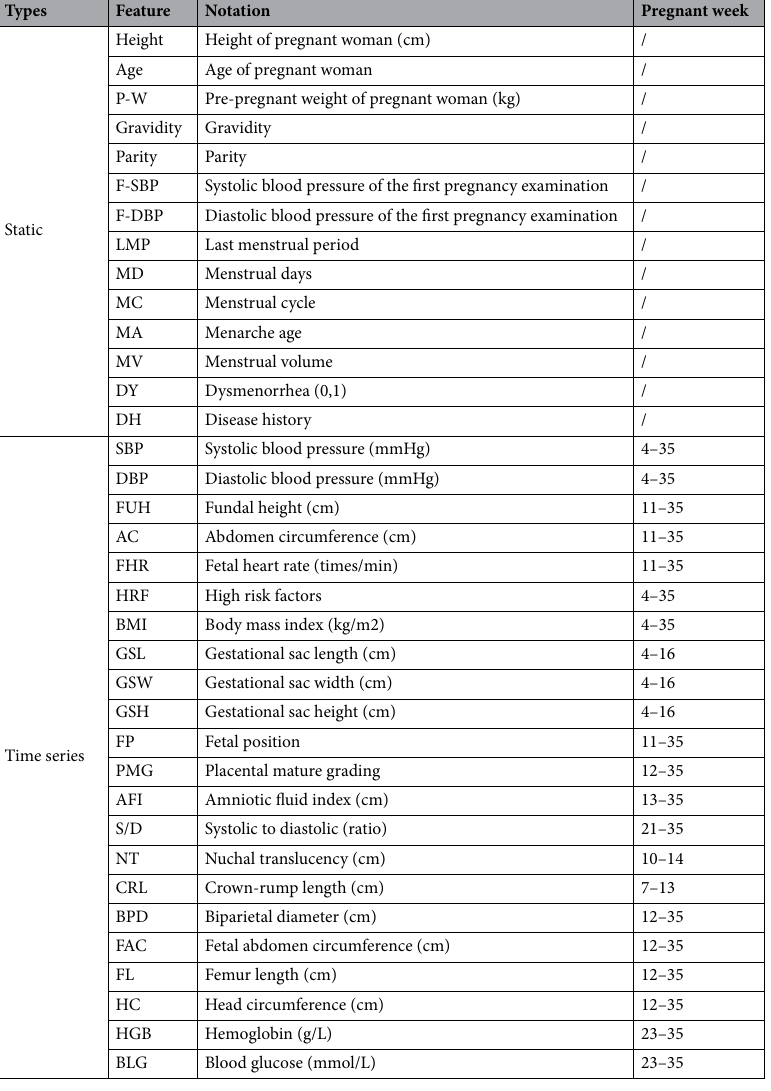
Table 1. Features of the pregnancy